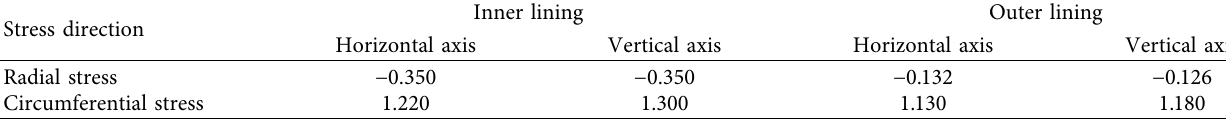
Table 3: Radial and circumferential stresses on the horizontal axis (MPa).